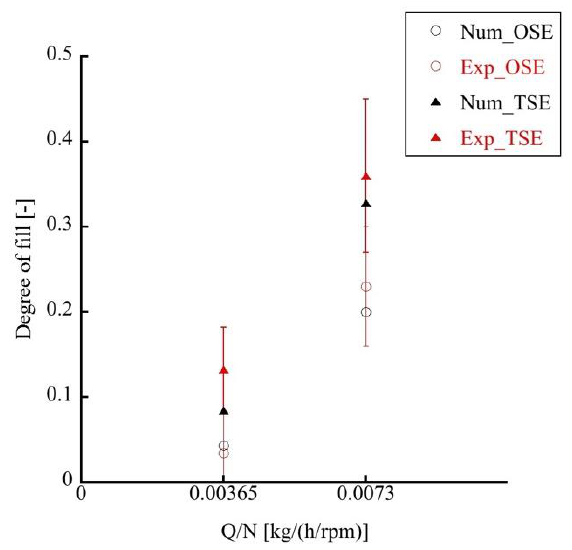
Figure 6. Measured and calculated degrees of fill in twin- and octa-screw extrusions.